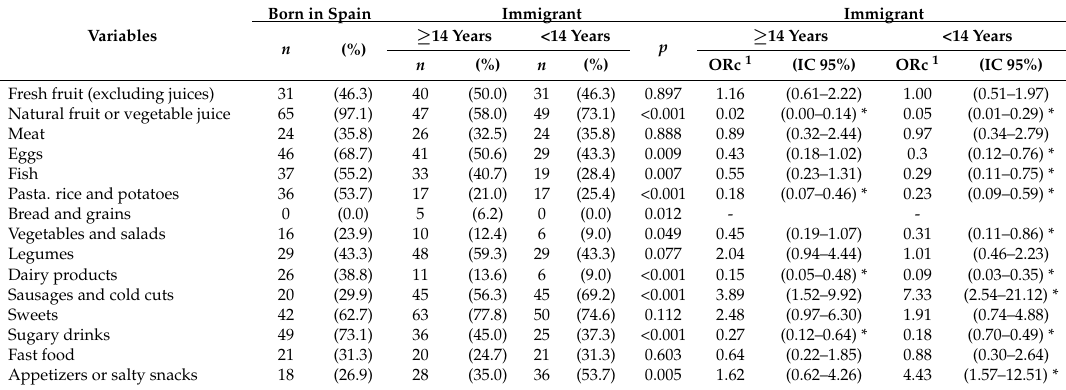
Table 2. Frequency and Association (Odds Ratio with 95% Confidence Intervals) of Adherence to Dietary Recommendations for Food Groups by Migratory